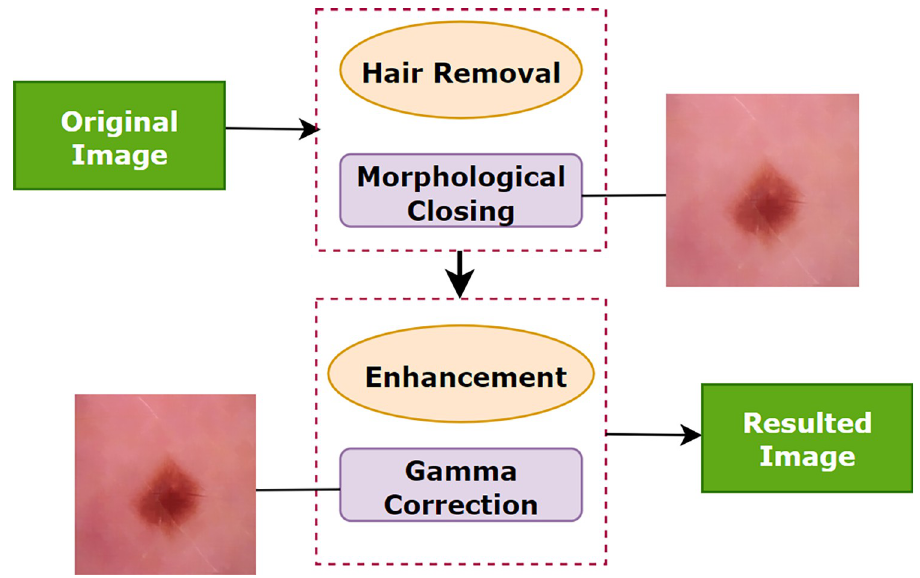
Fig 4. Steps performed for image pre-processing.